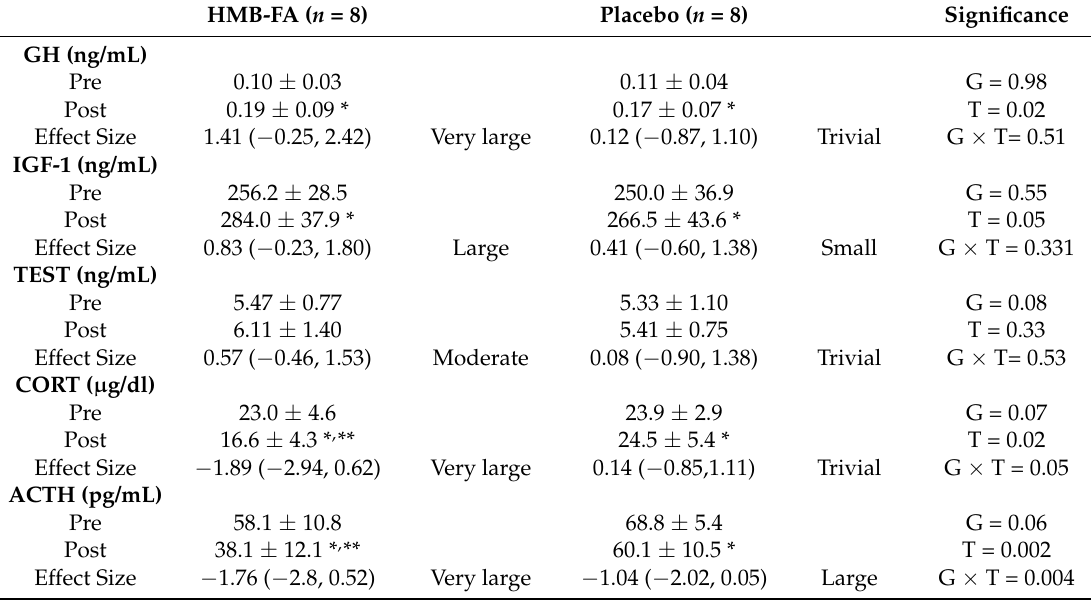
Table 3. Changes in hormonal responses to six-week training intervention (mean ±